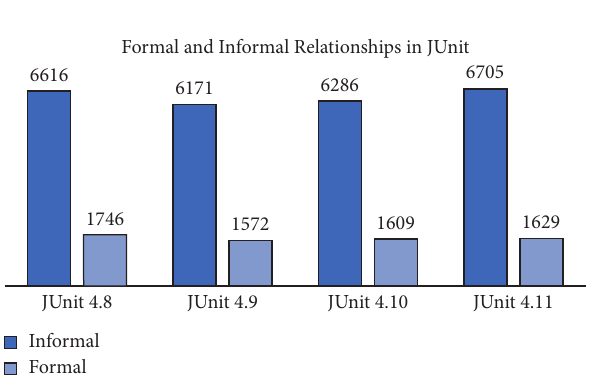
Figure 13: Count of formal and informal relationships in Junit.